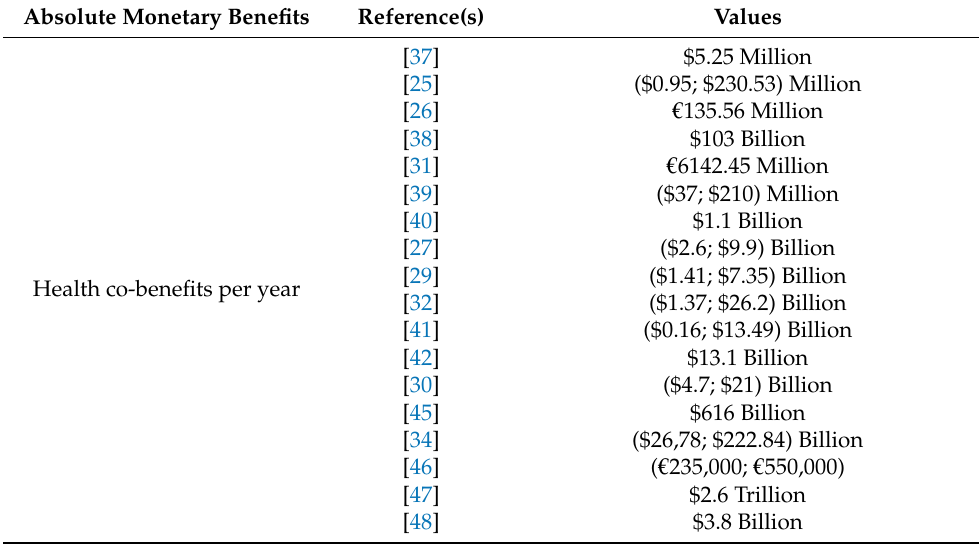
Table 10. Absolute monetary benefits (source: own elaboration).